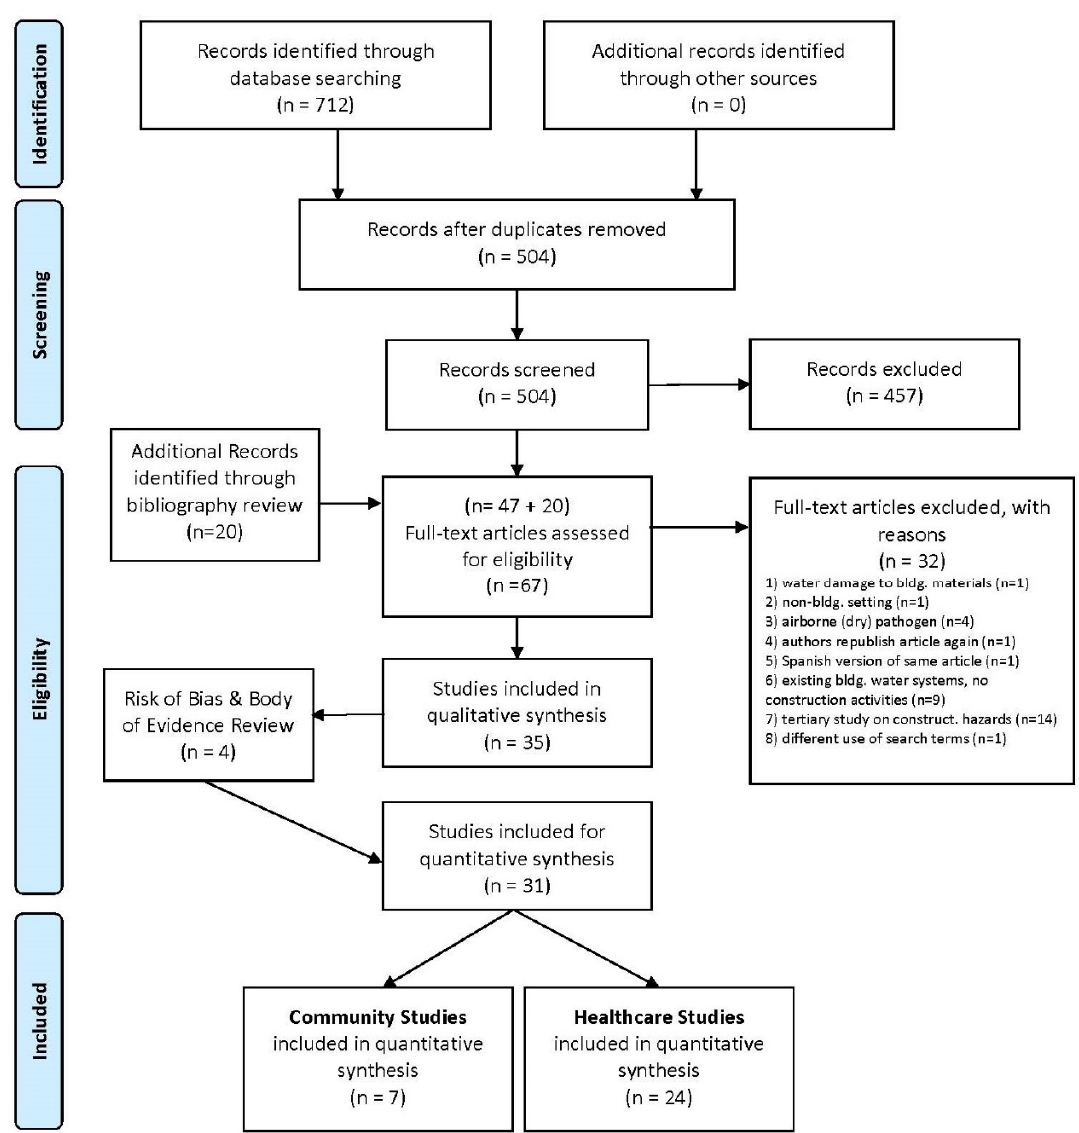
Figure 1. Article selection process [12] .